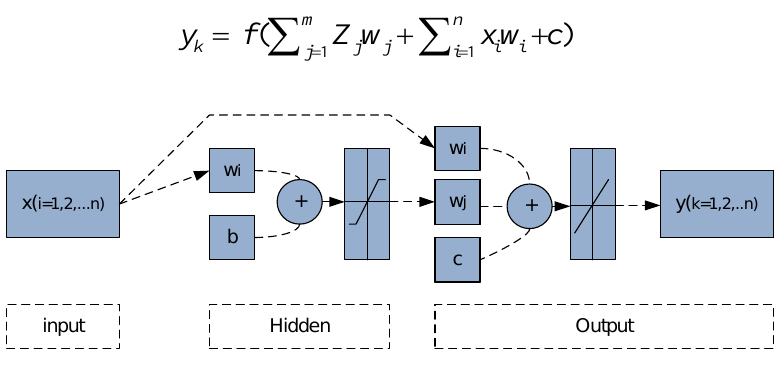
Figure 3. Cascade- forward Back-propagation neural networks architecture.